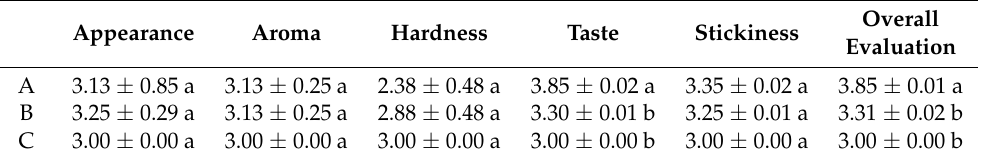
Table 6. Result of sensory test of three kinds of the blended meals. Appearance Aroma Hardness Taste Stickiness